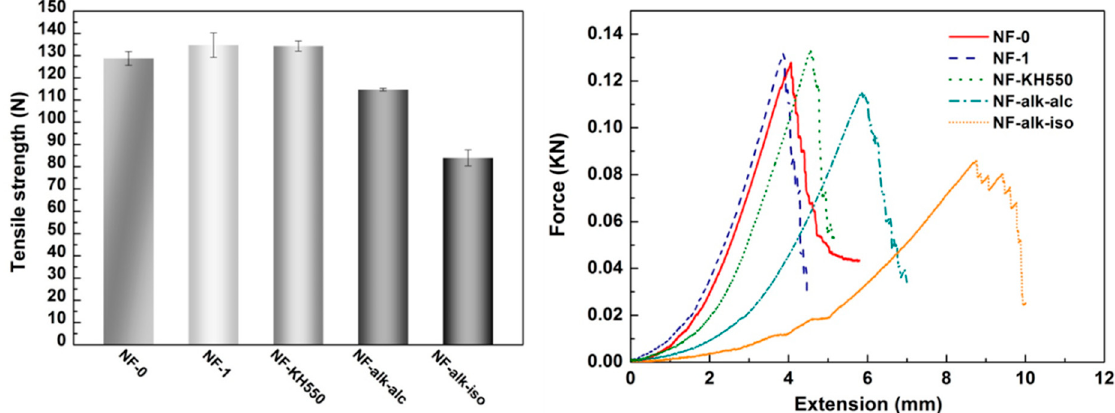
Figure 7. The mechanical properties of different modified ramie fabrics.